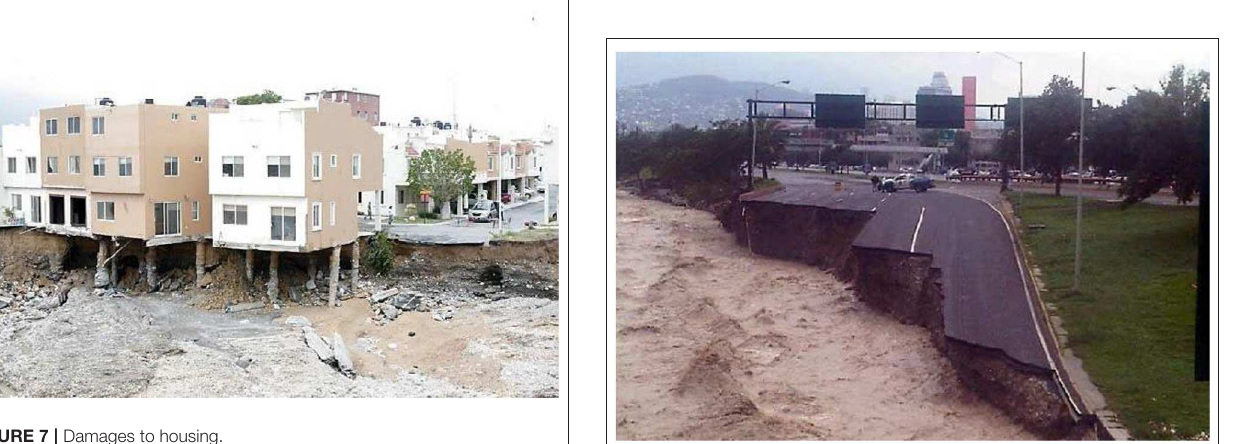
FIGURE 9 | Partial destruction of Constitucion Avenue in central Monterrey. Courtesy from El